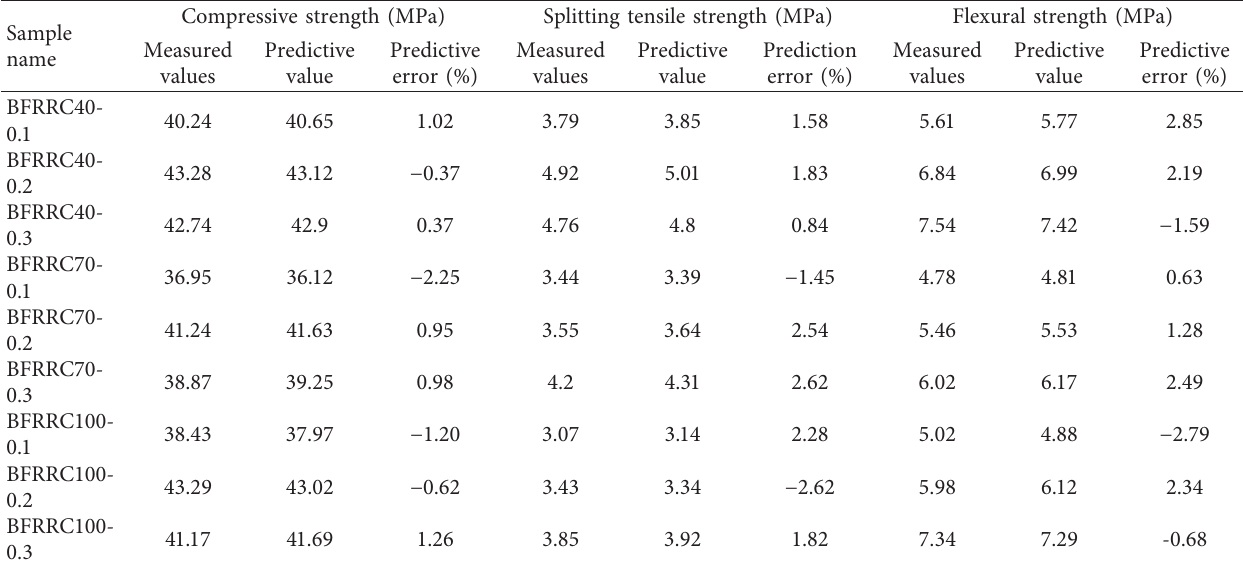
Table 5: Comparison of strength predictive and measured values of